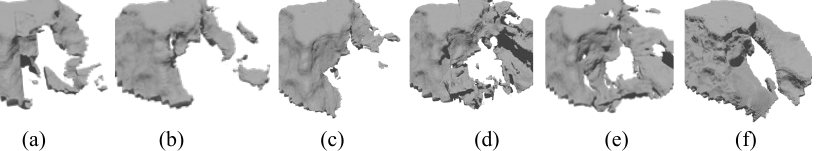
Figure 12. The visualization result of ablation experiments. ( a ) Our baseline; ( b ) NeuralRecon ( c ) STA; ( d ) STA+VRM; ( e ) STA+VRM+FE; ( f ) ground